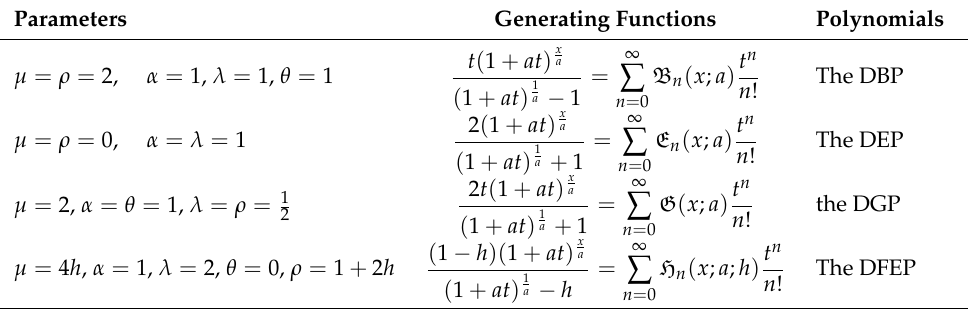
Table 1. Parameters for the degenerate polynomials.